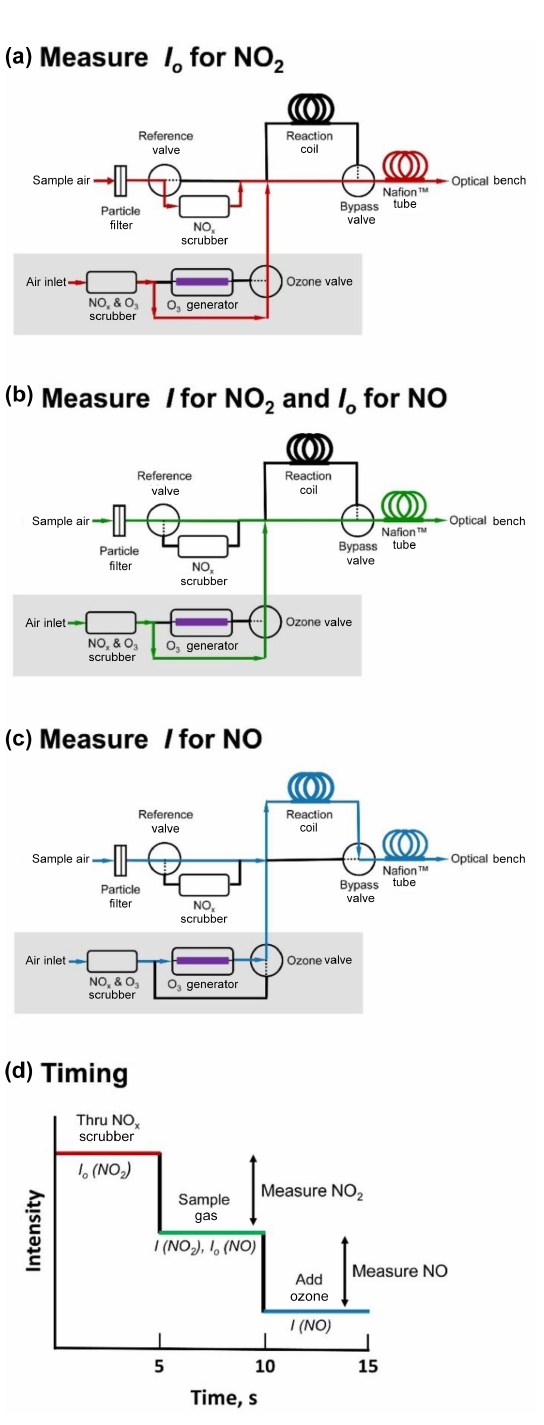
Figure 3. Schematic diagram showing the three-way valve states for measuring (a) I o for NO 2 ; (b) I for NO 2 and I o for NO; and (c) I for NO. Flow path is shown in red, green, and blue for panels (a) , (b) , and (c) , respectively. Panel (d) depicts an idealized measure- ment sequence corresponding to the three steps shown in panels (a) – (c) and indicates the timing of the three measurement